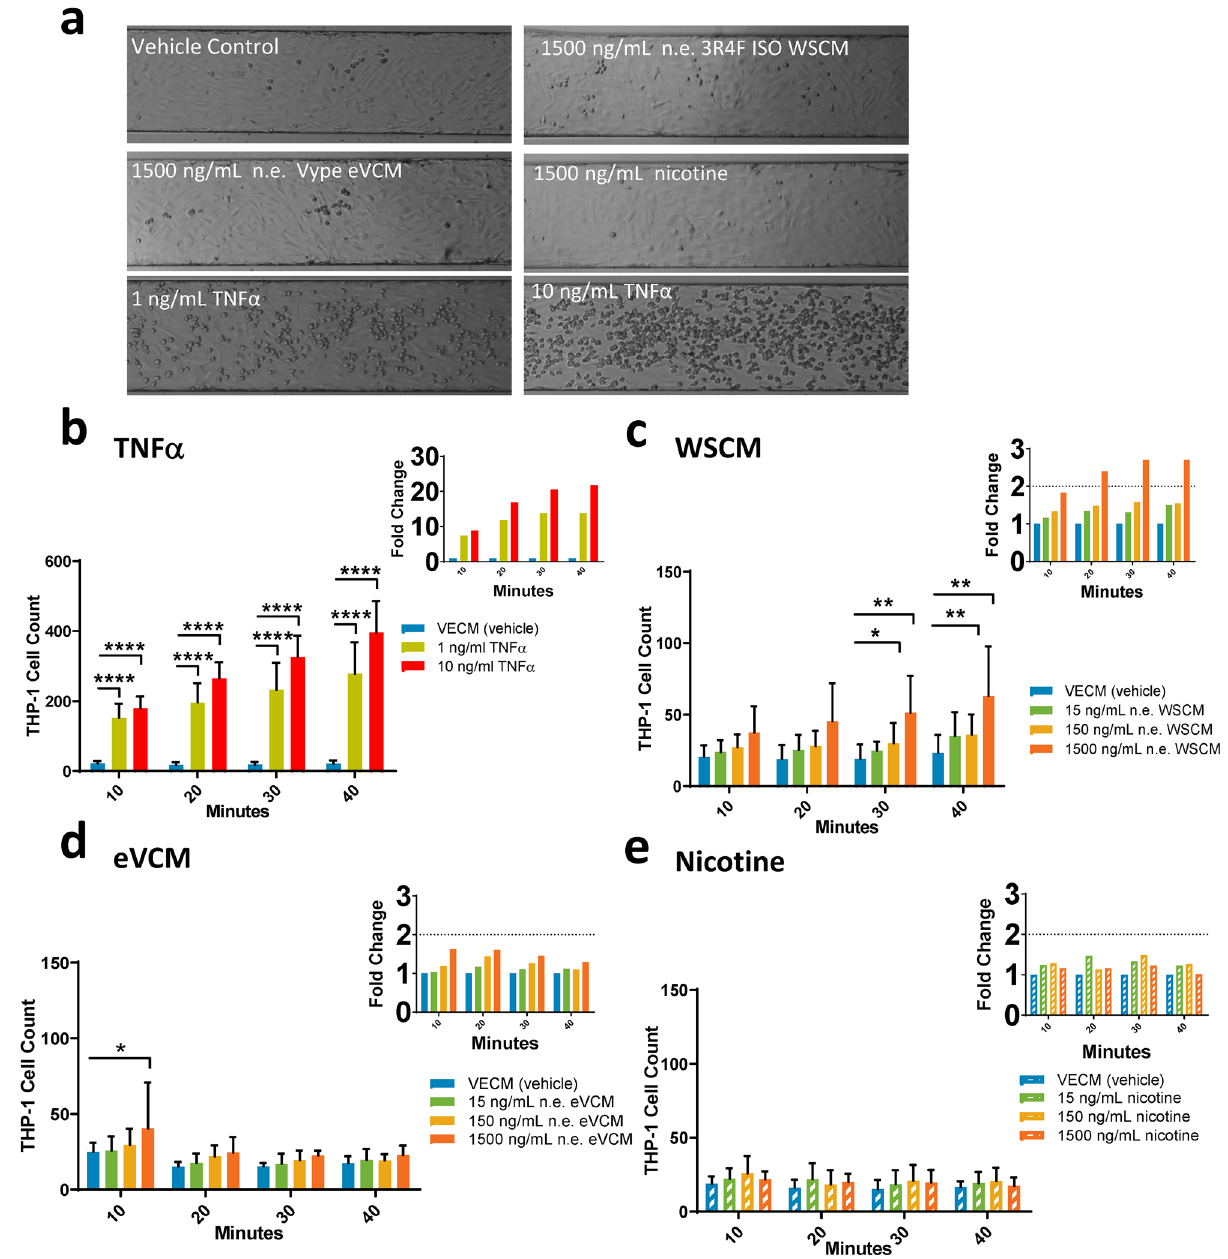
Figure 2. Monocyte adhesion to HAECs following 24 h test article exposure in the BioFlux microfluidic system. ( a ) Representative images of monocyte adhesion to HAECs following 24 h HAEC exposure to test article in BioFlux microfluidic channels. Brightfield images were captured after the 40 min adhesion period using a Zeiss Axio Observer.Z1 microscope (×10 magnification). Quantification of monocyte adhesion to HAECs over a course of adhesion periods (10, 20, 30 and 40 min) following 24 h HAEC exposure to a dose range of ( b ) TNFα, ( c ) WSCM, ( d ) eVCM or ( e ) nicotine in BioFlux microfluidic channels with fold change graphs inset. Two-way ANOVA with Dunnett’s multiple comparisons between vehicle control and each test article concentration. Error bars denote ± SD (n = 6), TNFα (n = 30); *p < 0.05 **p < 0.01 p < 0.001 p <